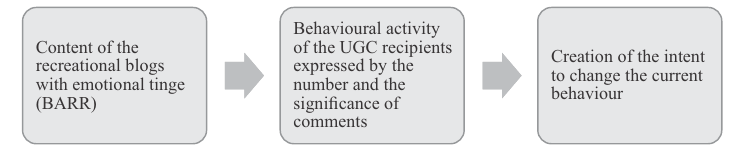
Fig. 1. Framework research model assumptions Source : Own